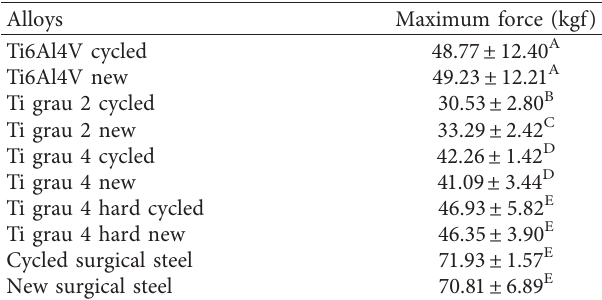
Table 5: Means and standard deviations for maximum force (kgf) as a function of alloy type and aging (new and cycled), independent of connection